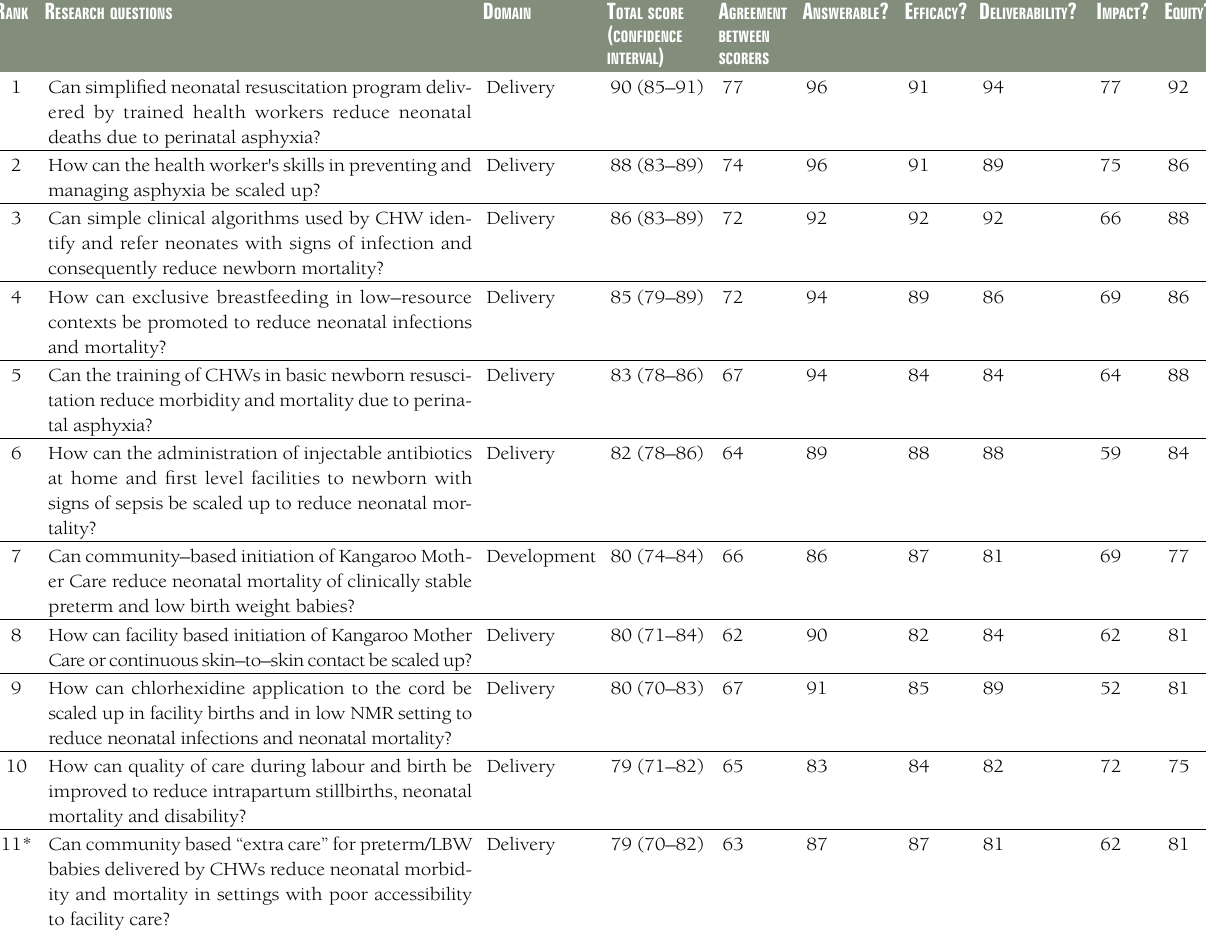
Table 1. Top ten research priorities for improving newborn health and birth outcomes by 2025 as ranked by 91 experts R ank R eseaRch questions